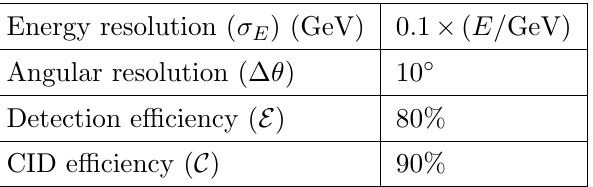
Table 2. The detector characteristics used in the simulations. We use the same detector properties for (cid:22) (cid:0) and (cid:22) + events. isotropic decay. The mass of dark matter is shared by (cid:12)nal (cid:23) and (cid:22) (cid:23) , thus, their energy spectrum can be written